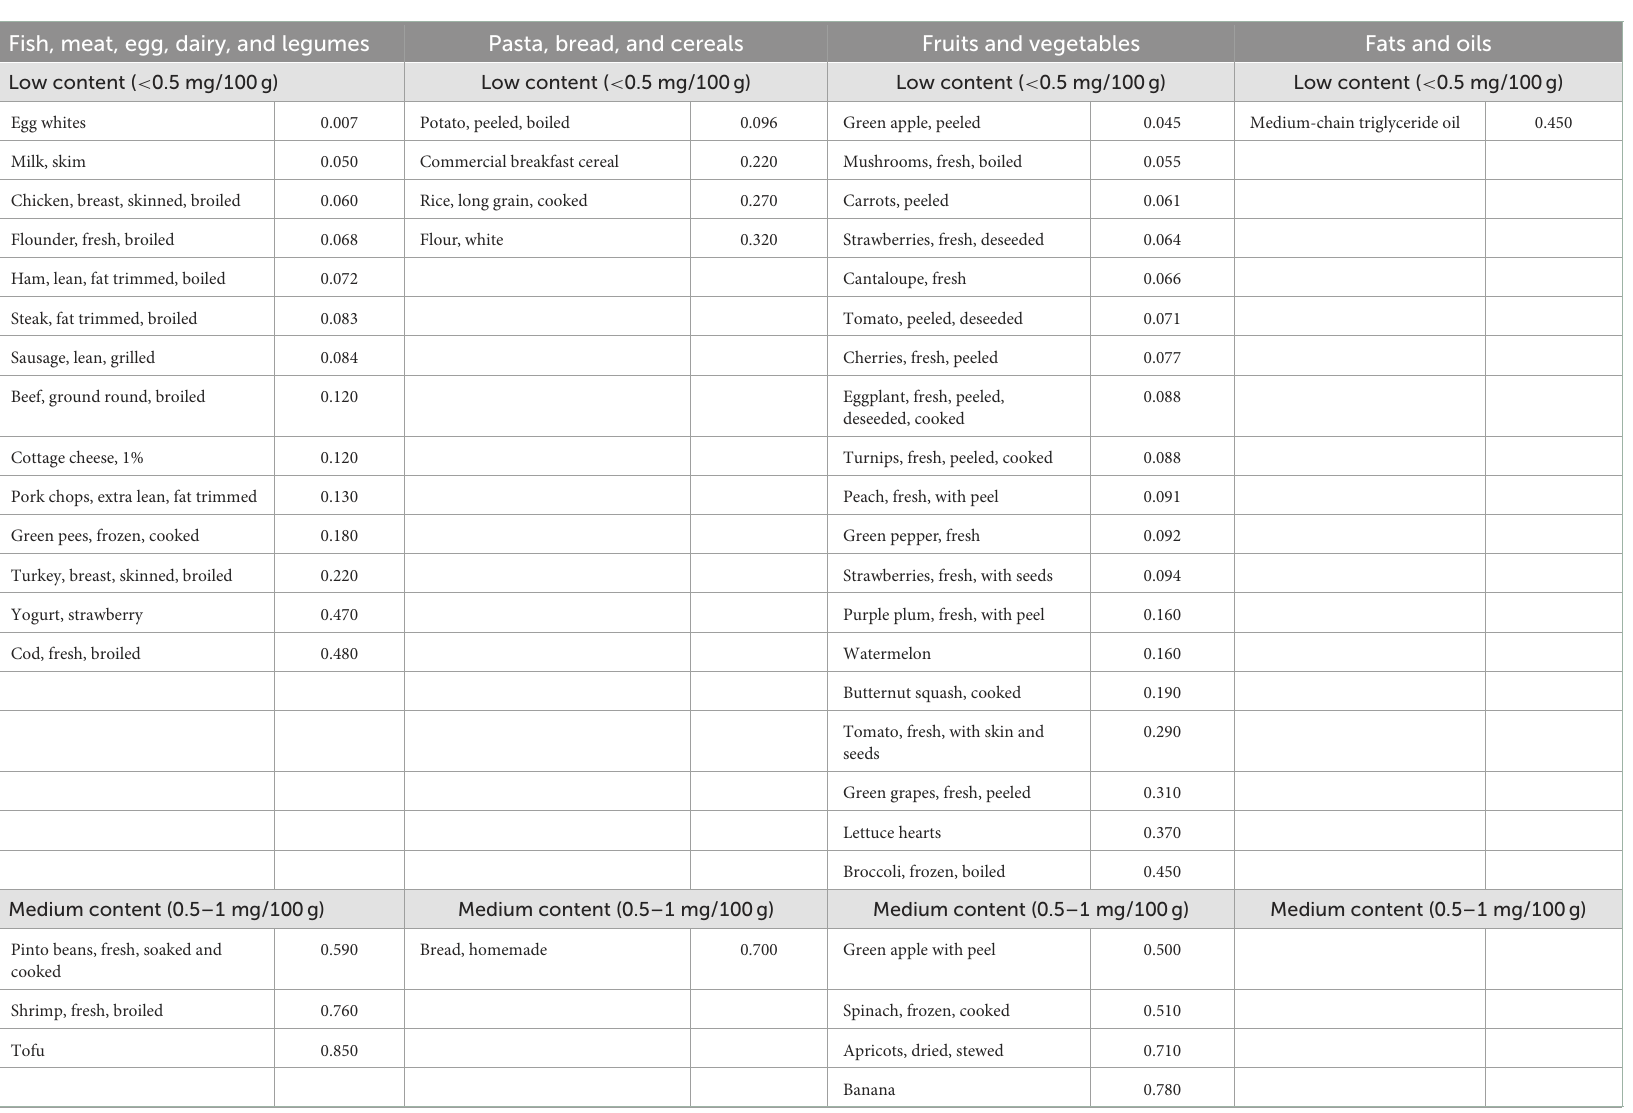
TABLE 2 Content of C26:0 (mg) in 100g of different edible foods. Fish, meat, egg, dairy, and legumes Pasta, bread, and cereals Fruits and vegetables Fats and